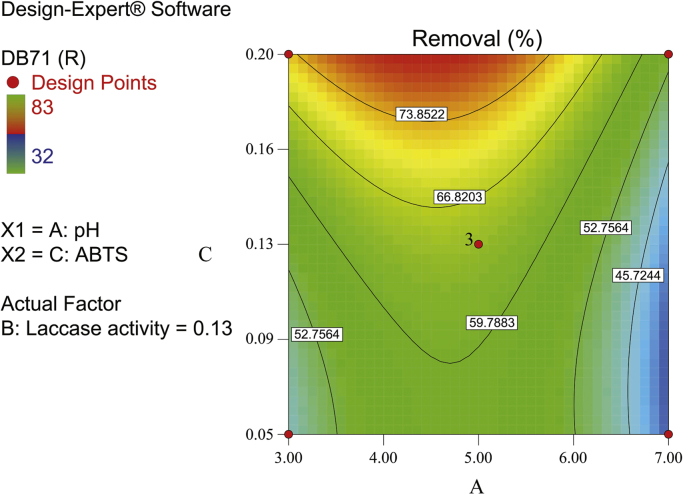
Contour plot of the interaction effects of pH (A) and ABTS dose (C) on DB71 removal.